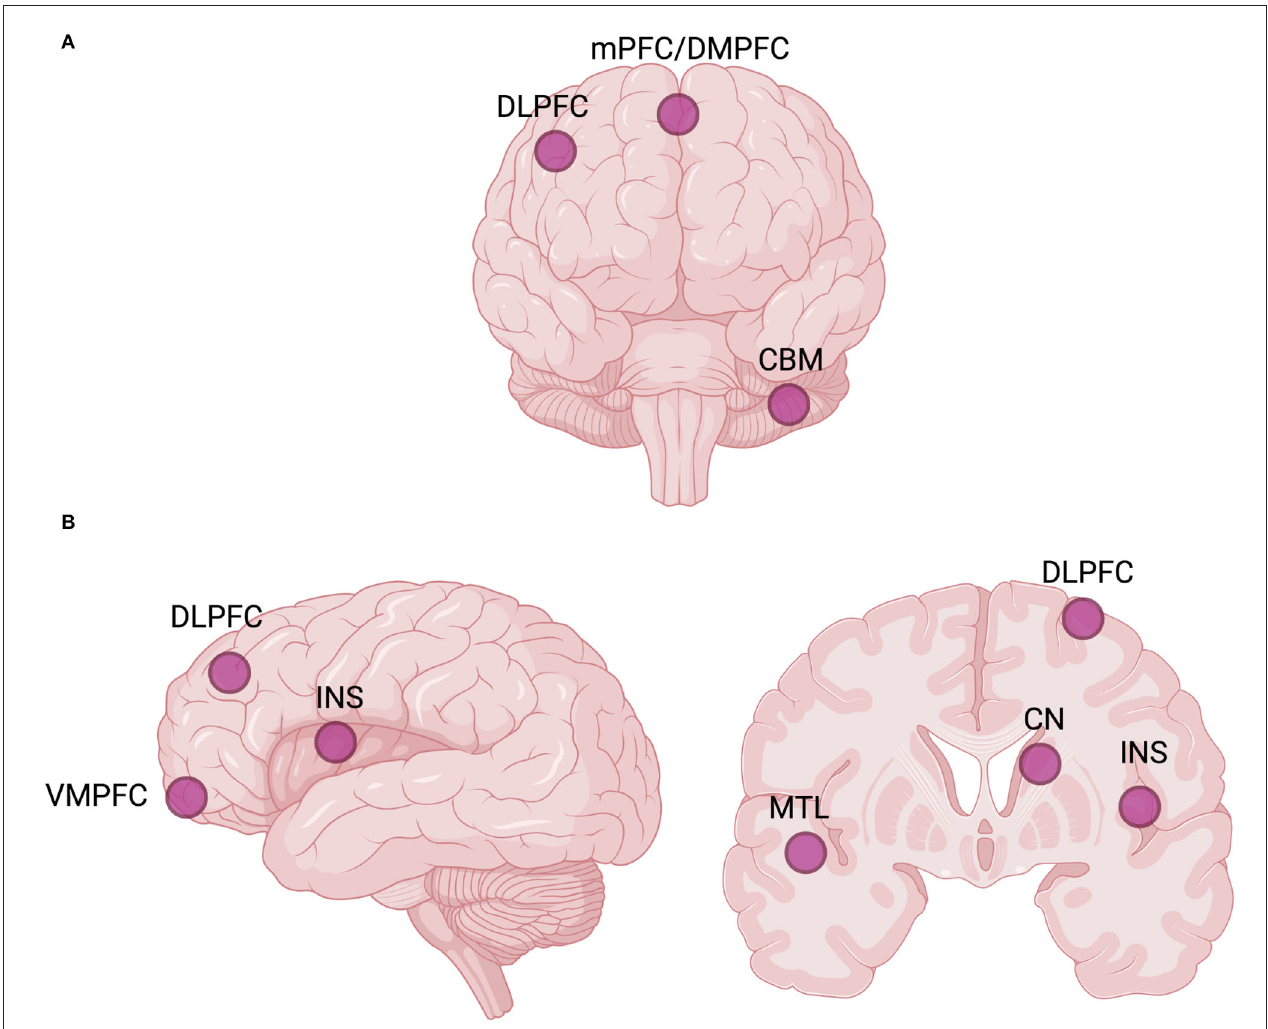
FIGURE 4 | Global brain connectivity (GBC) hubs, or network nodes interconnected with the rest of the brain, may be investigated as potential biomarkers of rapid antidepressant response to ketamine and other glutamatergic interventions ( 131–133). (A) Commonly reported GBC hubs targeted by ketamine. (B) Commonly reported GBC hubs implicated in predicting rapid antidepressant treatment response to ketamine. The laterality of hubs is not considered. Created with BioRender.com, RRID:SCR_018361. CBM, cerebellum; CN, caudate nucleus; DLPFC, dorsolateral prefrontal cortex; DMPFC, dorsomedial prefrontal cortex; INS, insula; mPFC, medial prefrontal cortex; MTL, medial temporal lobe; VMPFC, ventromedial prefrontal